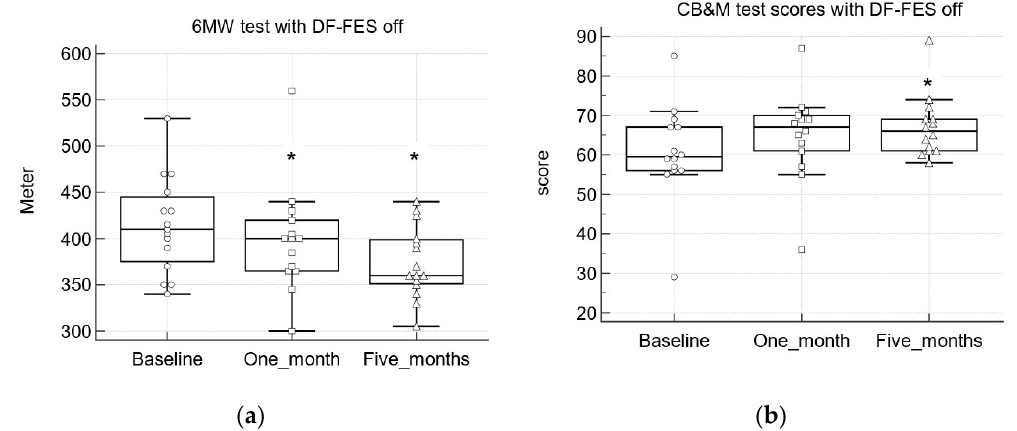
Figure 2. Repeated motor function test scores with DF-FES off, at baseline and after one month and five months of device use. Error bars represent 95% CI of median. Dots represent individual data. CB&M = Community Balance and Mobility Scale; 6MWT = Six-Minute Walk Test; * p < 0.05 in comparison to baseline (Wilcoxon test).